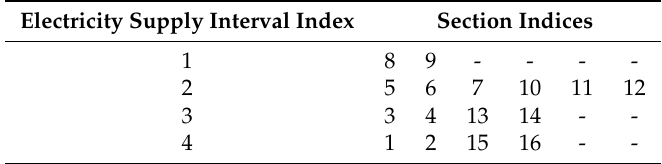
Table 3. Electricity supply intervals distribution of Yanfang Line.